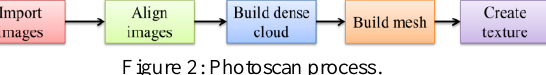
Figure 2: Photoscan process.